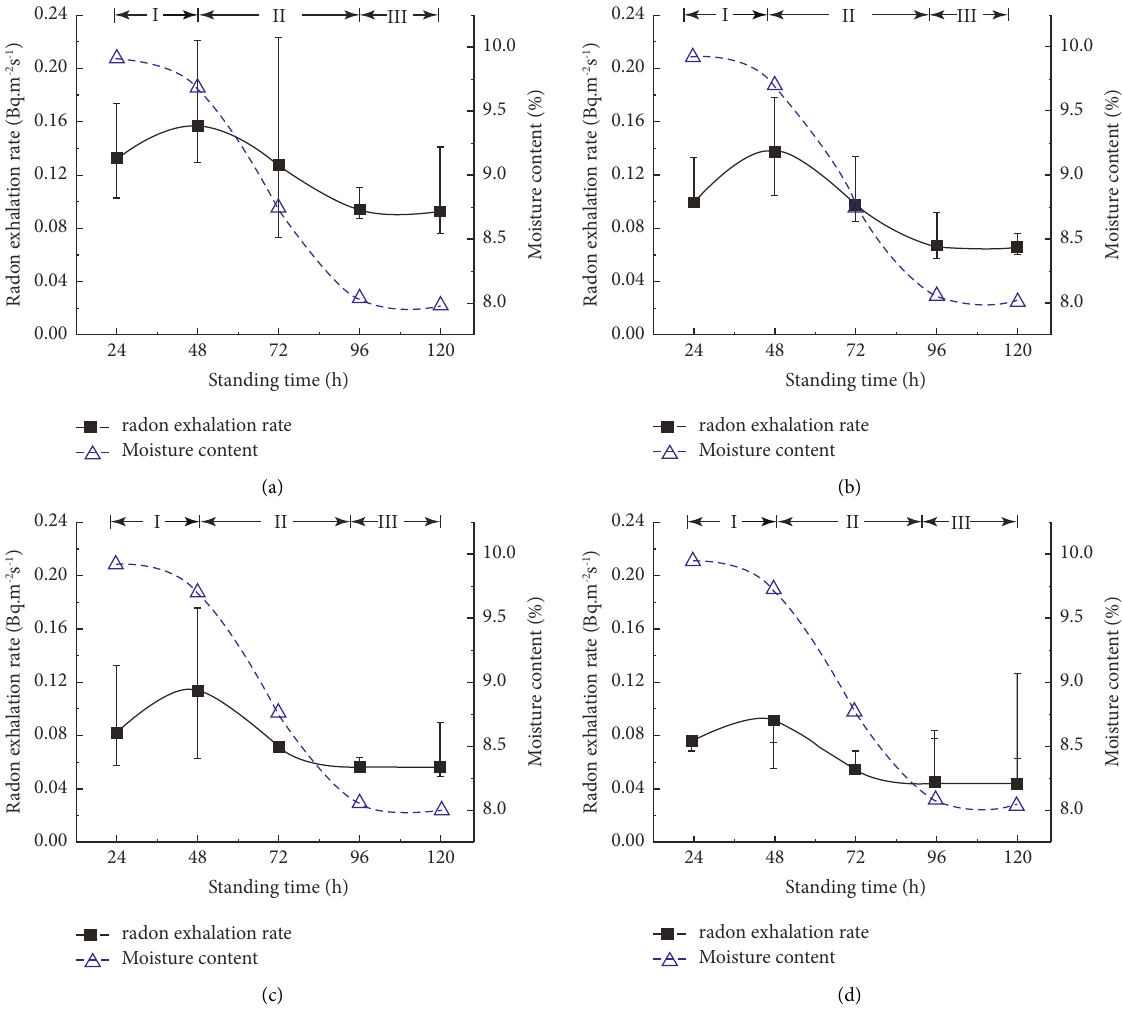
Figure 4: Variation curves of radon exhalation rate and moisture content, compaction degree is 0.56 (see Figure 4(a)), compaction degree is 0.62 (see Figure 4(b)), compaction degree is 0.70 (see Figure 4(c)), and compaction degree is 0.80 (see Figure